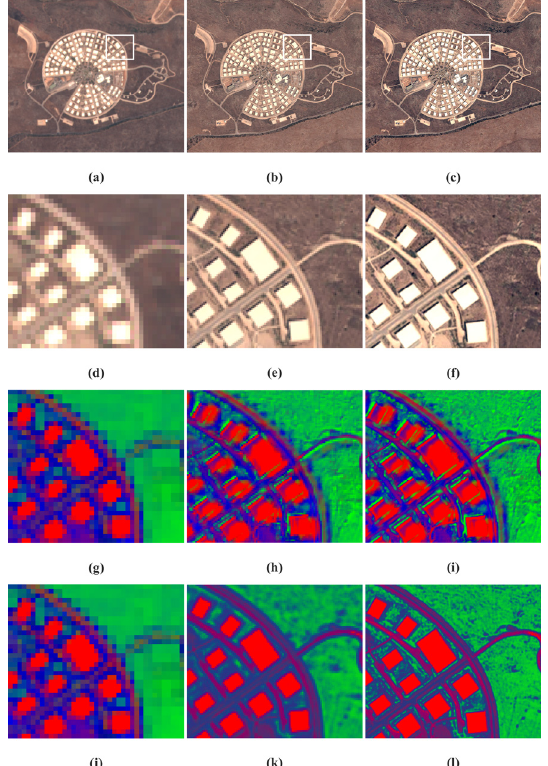
Figure 19. An RGB composite of a selected area from the Sentinel image with a 10 m resolution ( a ), and Google Earth RGB images with SRs of 3 m ( b ) and 1 m ( c ). Corresponding zoom-ins on the area marked by a white rectangle are presented in ( d ), ( e ), and ( f ), respectively. ( g ) and ( j ) present zoom-ins on the fraction map of three dominant EMs in the selected area, as obtained by SUnSAL from the Sentinel image with an LSR 10 m. ( h ) and ( i ) present fraction maps as obtained by SUnSAL for the HSR 3 m and 1 m images retrieved by the PSQ-PS method and hierarchal PSQ-PS process, respectively. ( k ) and ( l ) present enhanced HSR 3 m and HSR 1 m fraction maps as obtained by the proposed fusion method DFuSIAL and the hierarchal DFuSIAL process, respectively.